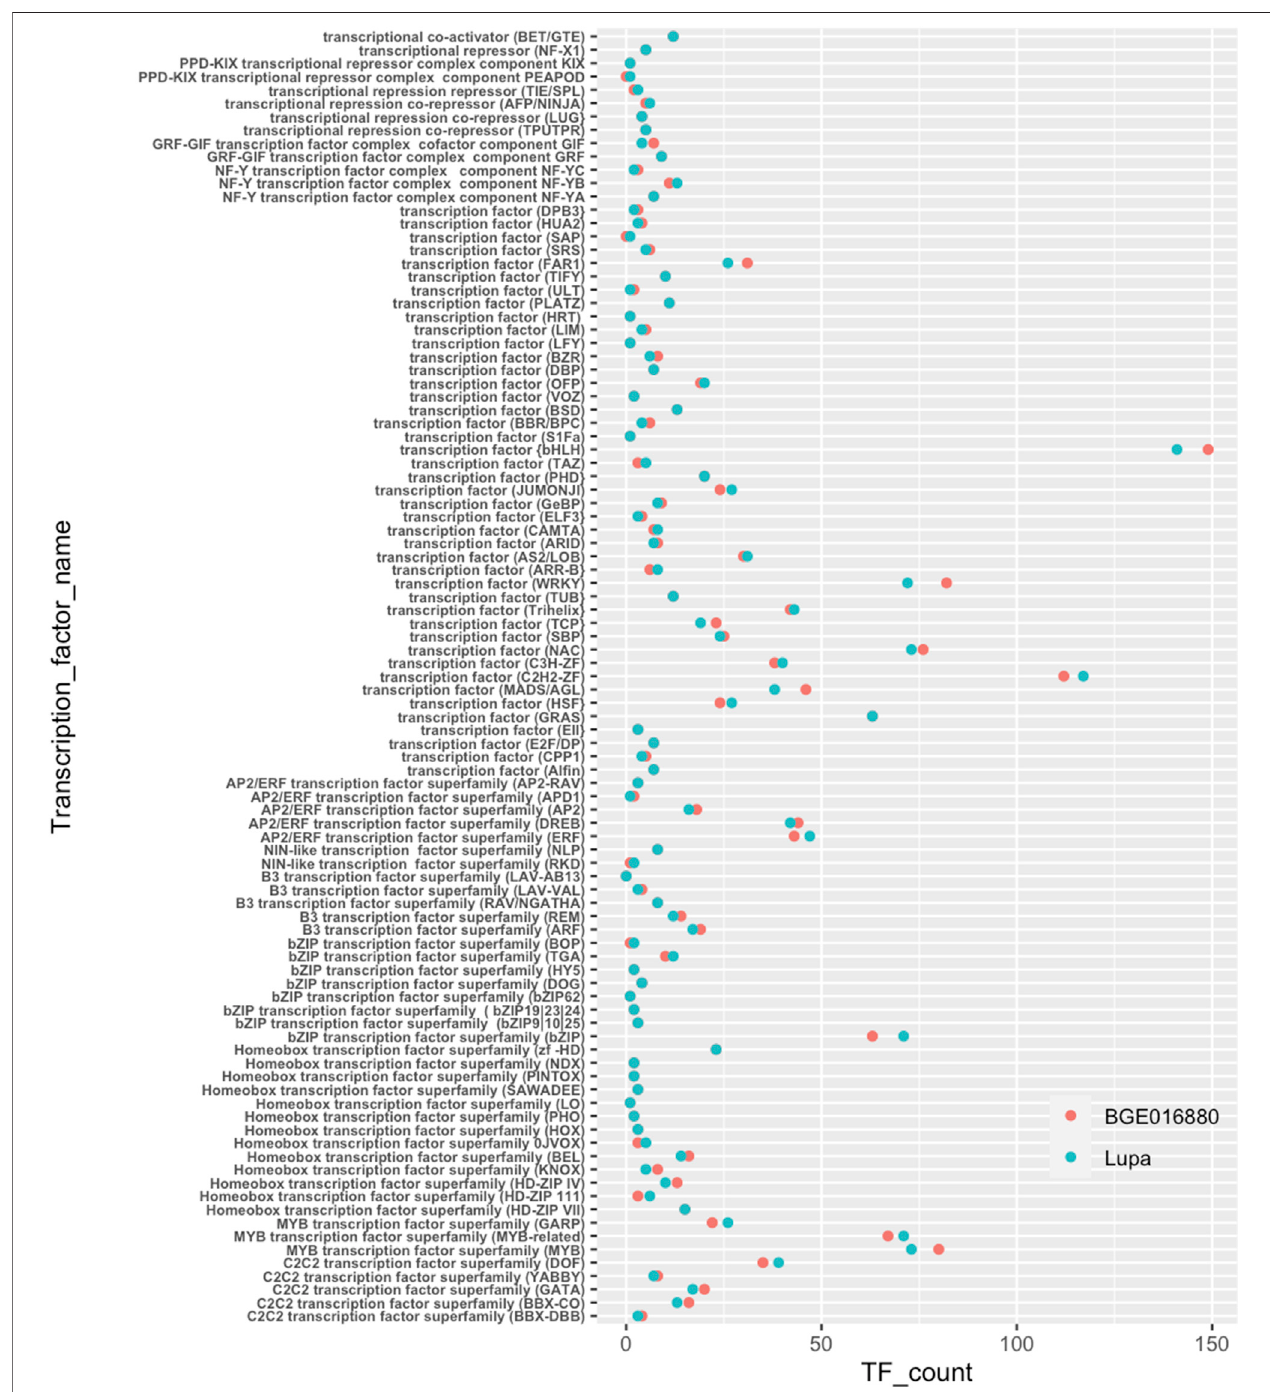
FIGURE 3 | Transcription factors annotated from de novo -assembled transcriptomes of L. orientalis BGE 016880 and L. culinaris cv Lupa. X -axis represents correspondent numbers of transcription factors from each category.